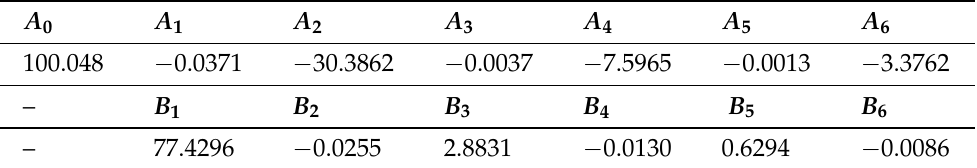
Table 6. First Fourier series coefficients for the paper